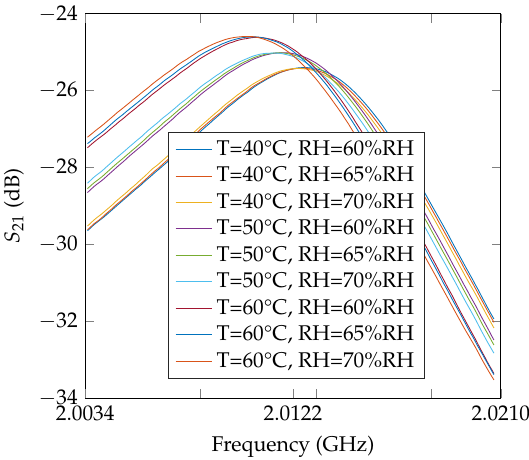
Figure 3. Simulated resonance frequency ( S 21 ) of a Rogers RO4003C tag for different values of temperature T and humidity RH .